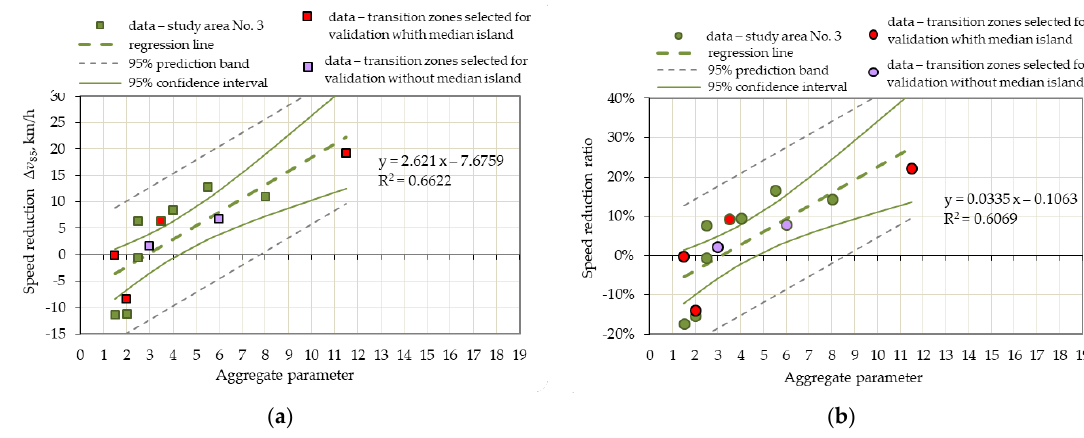
Figure 11. Linear regression function in the study area No. 3 defining the relationship between the aggregate parameter and speed reduction: ( a ) speed reduction ∆ v 85 ; ( b ) speed reduction ratio SRR. Source: own work of the authors.